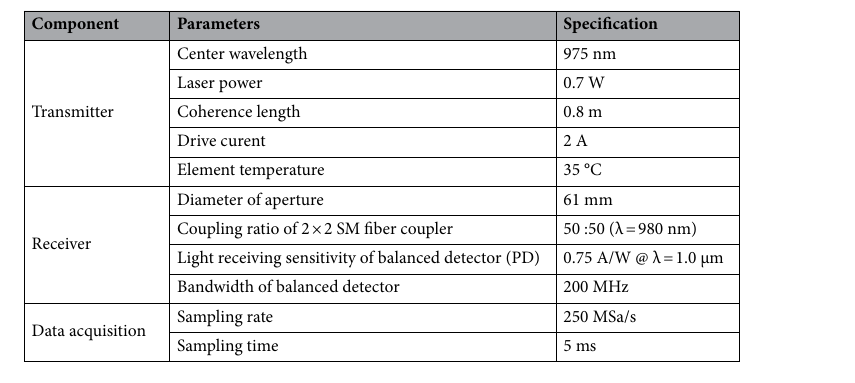
Table 1. Specifications of